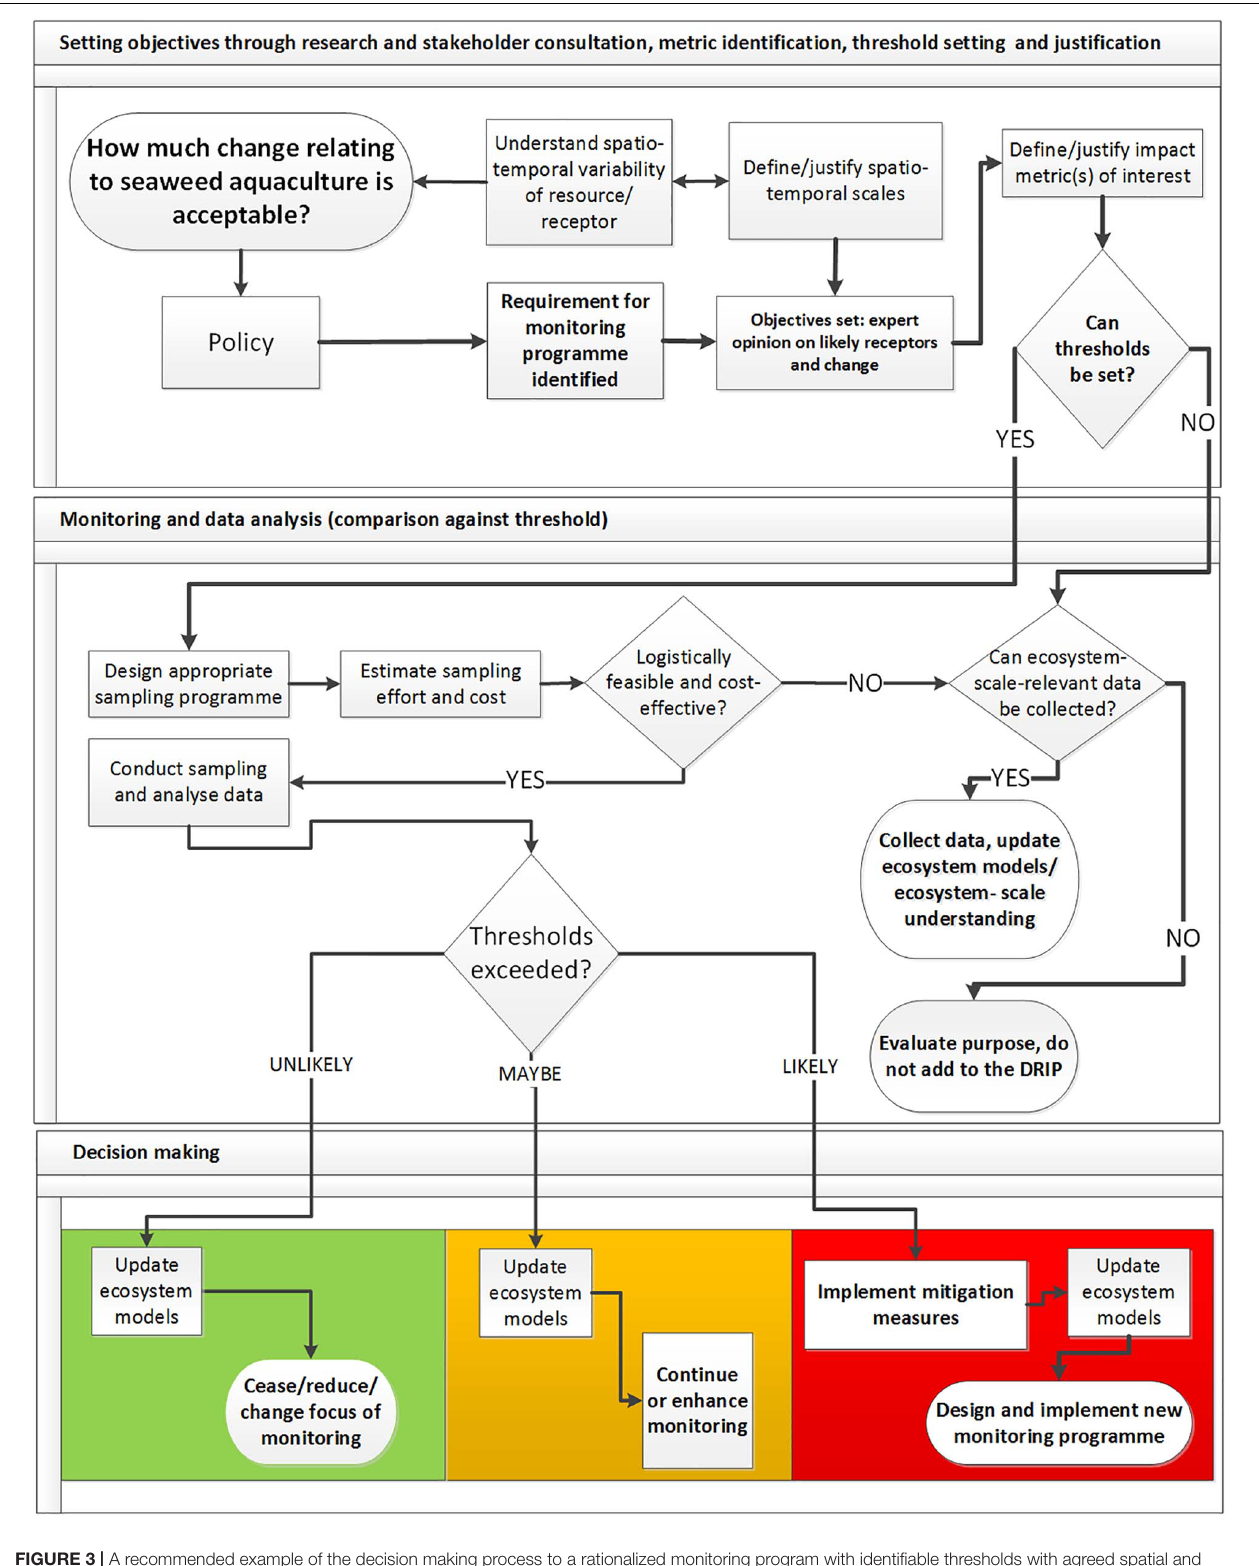
FIGURE 3 | A recommended example of the decision making process to a rationalized monitoring program with identifiable thresholds with agreed spatial and temporal domains [reprinted and adapted from Wilding et al. (2017) with permission from Elsevier].